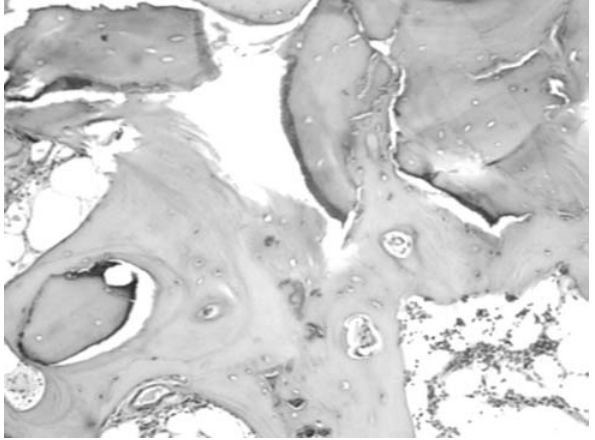
Figure 1 - Histology sample from a three-year follow-up human graft showing areas of new bone formation and residual spicules from the grafted material Table 2 - Clinical outcomes Clinic Evaluation Merle d’Aubigné and Postel